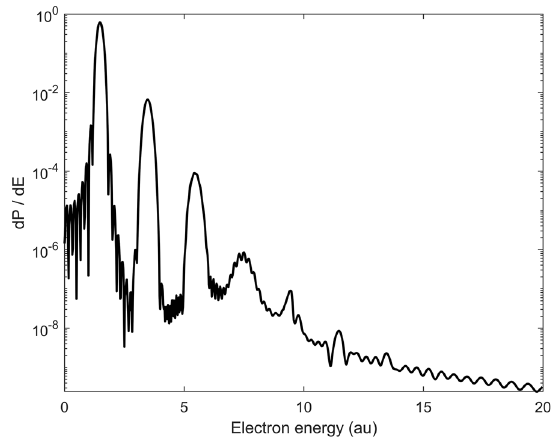
Figure 6. Ionization spectrum after passage of a 12 cycle pulse with field parameters: E ( t ) E sin (ω t ) , ω 2, E 0 1.0 0 = = =